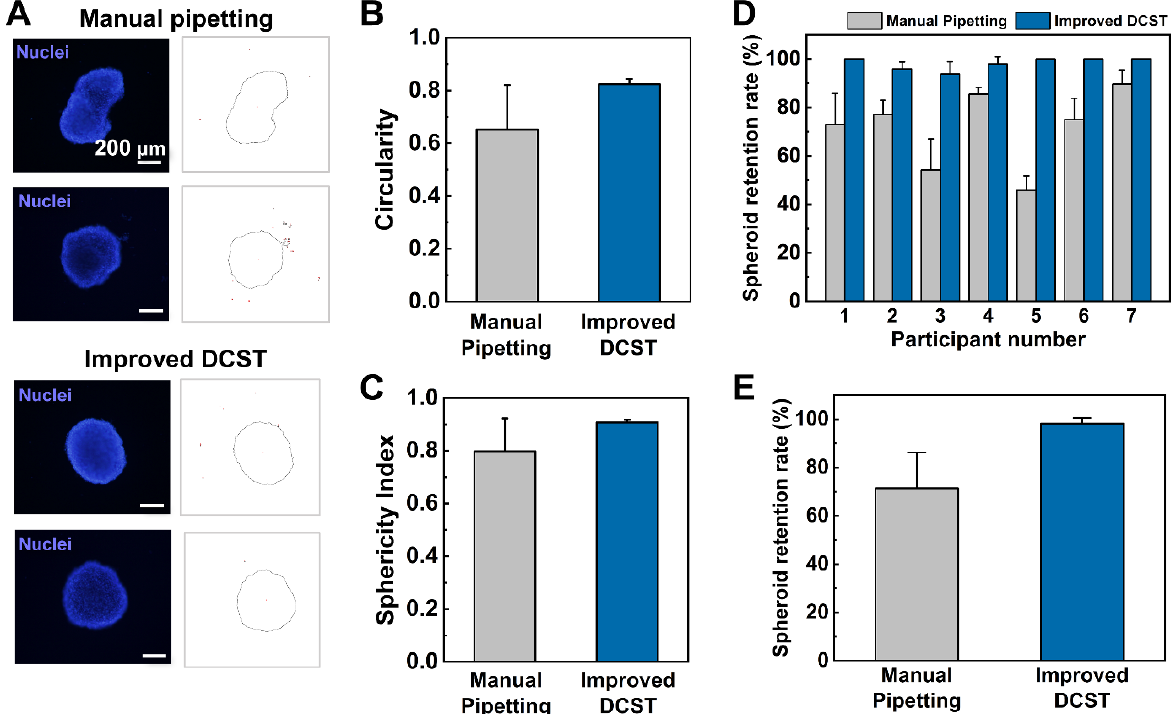
Figure 3. Characterization of the improved DCST method compared to the manual pipetting method. ( A ) Representative two images of the spheroids transferred by the manual pipetting method (left) and the improved DCST method (right). Blue: nuclei stained with Hoechst, black line: circumference of the spheroid. ( B ) A graph of circularity index of the improved DCST and manual pipetting methods. ( C ) A graph of the sphericity index of the improved DCST and manual pipetting methods. ( D ) A graph of the difference in spheroid retention rate between the improved DCST and manual pipetting methods of each participant. ( E ) The comparison of the average spheroid retention rate between the improved DCST and manual pipetting methods.